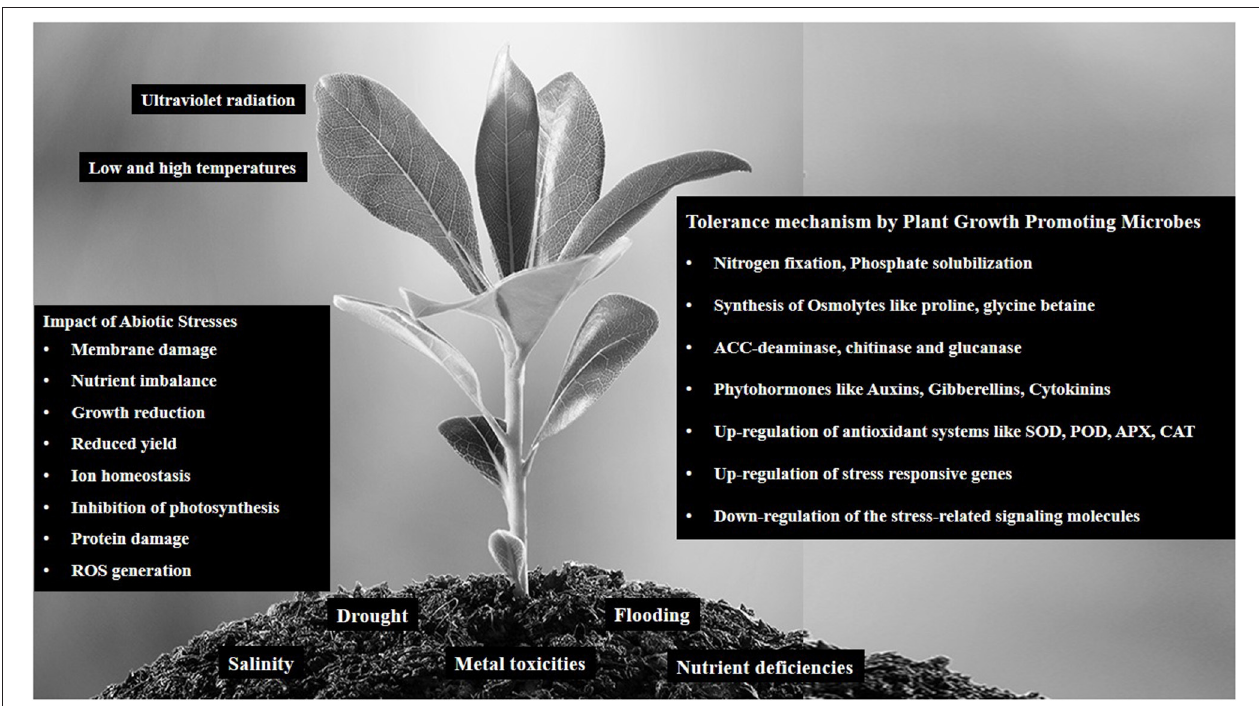
FIGURE 1 | Abiotic stresses, it’s impact, and tolerance mechanisms by various Plant Growth Promoting